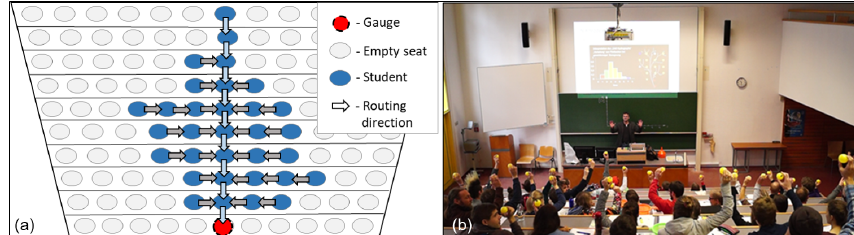
Figure 3. Catchment setup by 32 students: a sketch of the student seating, flow routing, and the gauge – blue arrows indicate the main stream channel within the catchment (a) . The “experimental” setup in the original lecture theatre (b) .